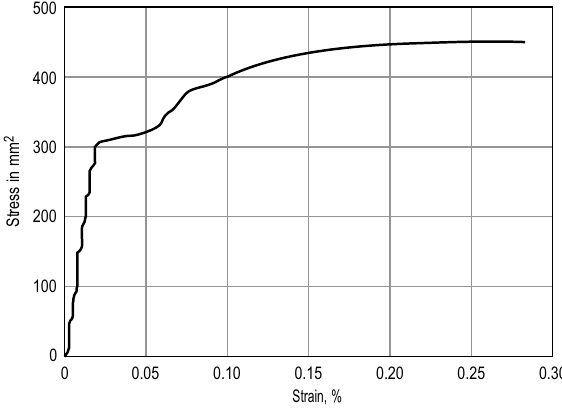
Fig. 4. Leg out-of-straightness